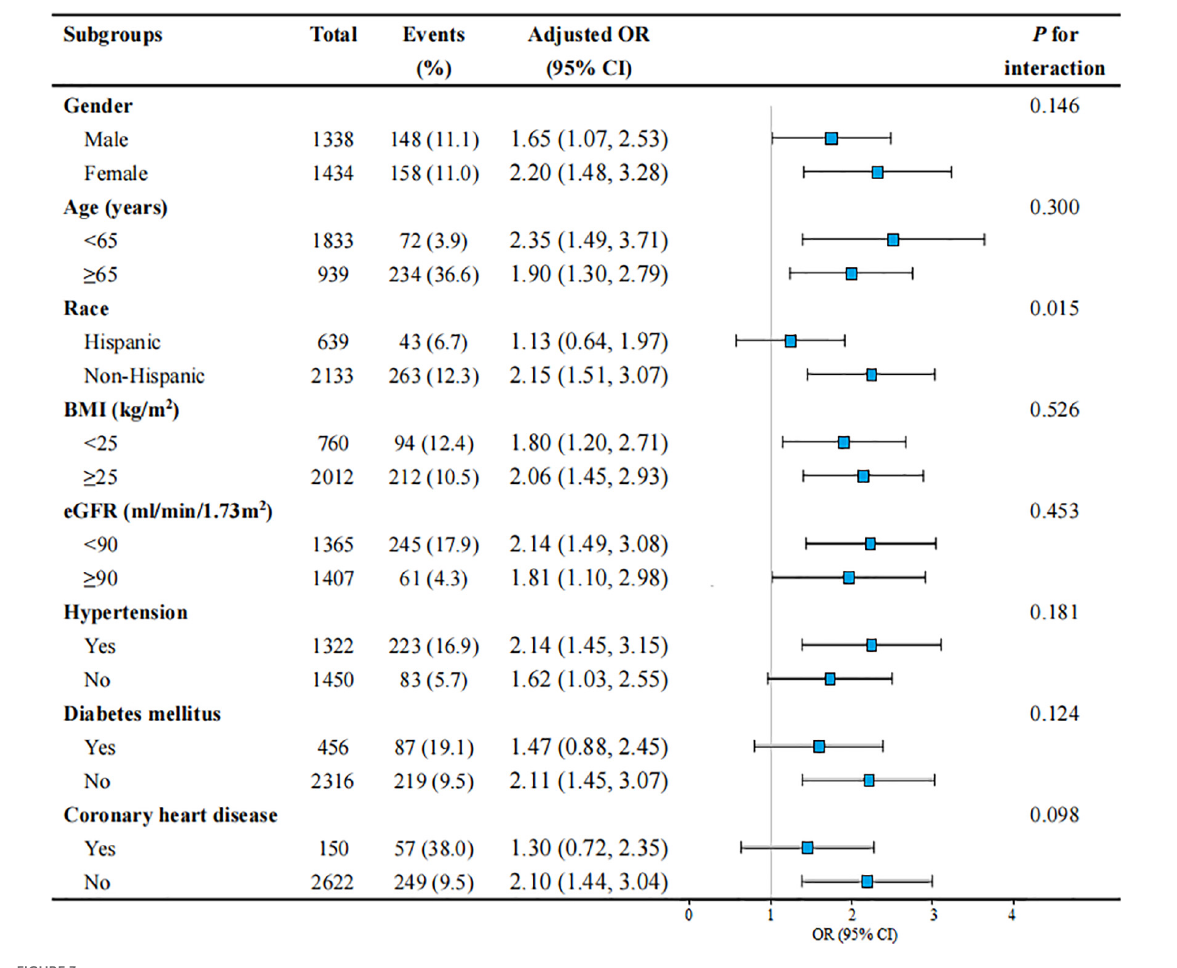
FIGURE3 Subgroup analyses of the association between WWI level and severe AAC in United States adults from NHANES 2013–2014. All presented covariates were adjusted (as Model 3) except the corresponding stratification variable. WWI, weight-adjusted-waist index; AAC, abdominal aortic calcification; US, the United States; NHANES, National Health and Nutrition Examination Survey; OR, odds ratio; CI, confidence interval; BMI, body mass index; eGFR, estimated glomerular filtration